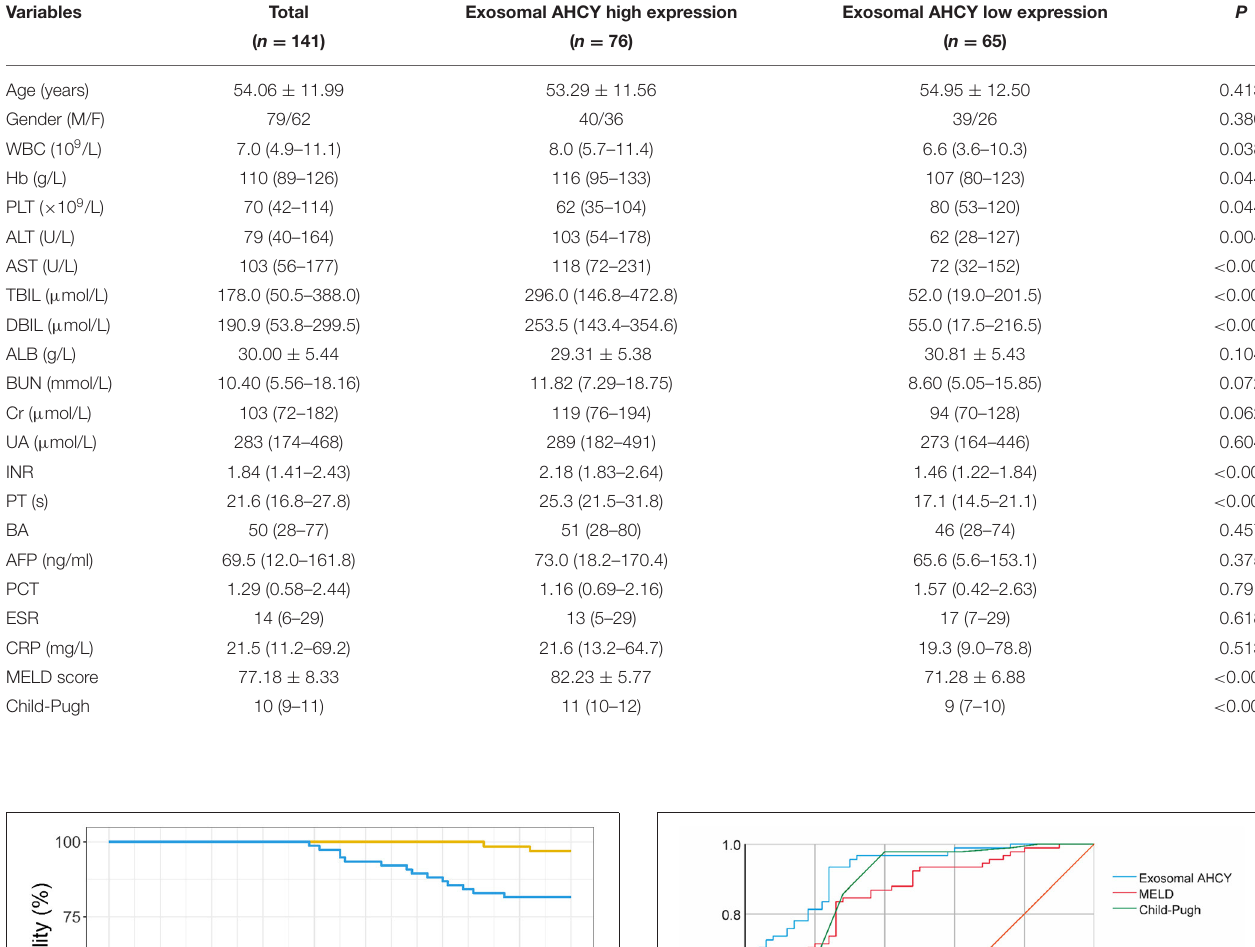
TABLE 2 | Baseline characteristics of exosomal AHCY high and low expression in HBV-LC group.